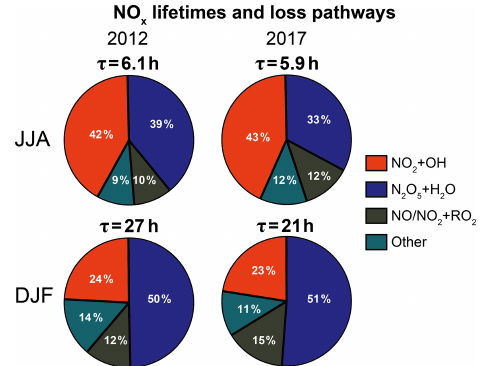
Figure 3. NO x lifetime ( τ ) and loss pathways in the boundary layer over central–eastern China. The lifetimes are the GEOS-Chem av- erages for the bottom 0–2km of the atmosphere over the domain de- lineated in Fig. 1, and the pie charts show the relative contributions of the different NO x sinks. For the lifetime calculation we define NO x as NO + NO 2 + NO 3 + 2N 2 O 5 + HONO + HNO 4 + ClNO 2 . Values are given for summer (JJA) and winter (DJF) 2012 and 2017. The sink from N 2 O 5 + H 2 O excludes the fraction that forms ClNO 2 . The sink from NO / NO 2 + RO 2 is the net flux, accounting for the partial recycling of the organic nitrates, and includes the contribu- tions from peroxyacyl nitrates (PANs). The “other” sinks include NO 3 + VOC reactions, NO 2 and NO 3 hydrolysis in aerosols, and NO x